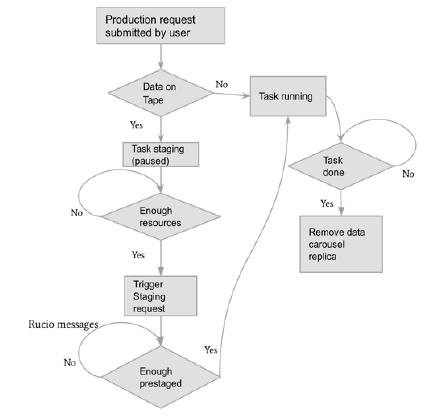
Fig. 2 : Workflow of the Data